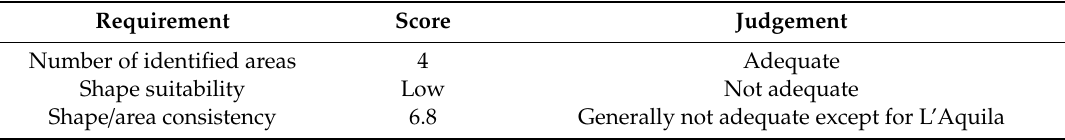
Table 4. Assessment of the criterion: subdivision by provinces.